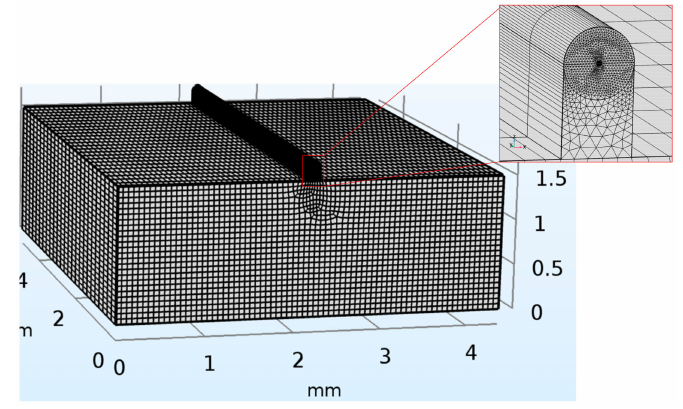
Figure 5. Finite-element (FE) mesh of strain